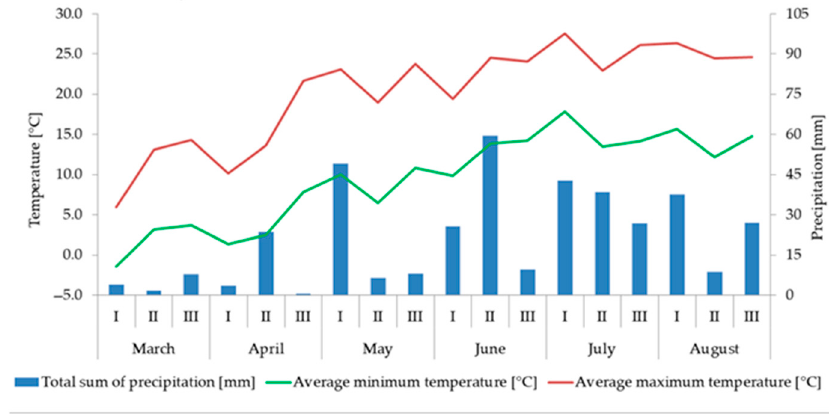
Figure 2. Decade weather condition in 2012 with marking minimum and maximum temperature.